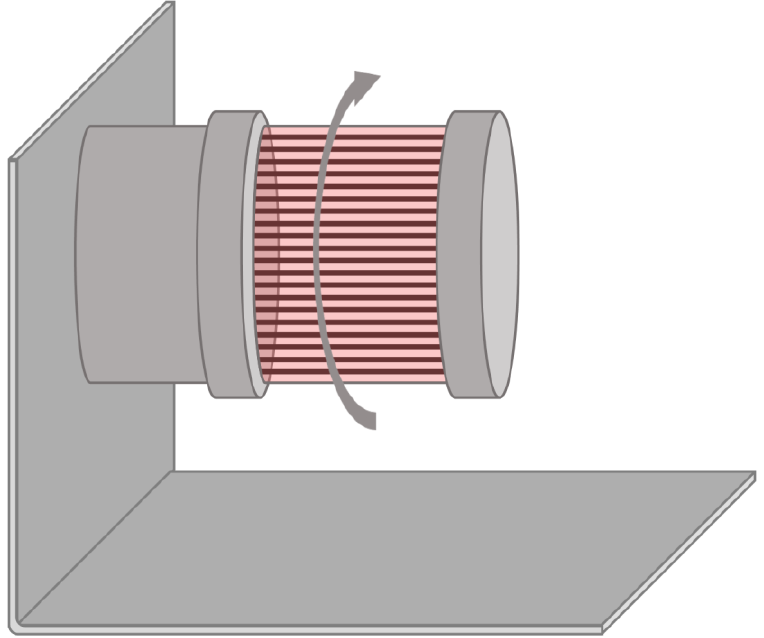
Figure 6. Schematics of a rotating bed bioreactor.